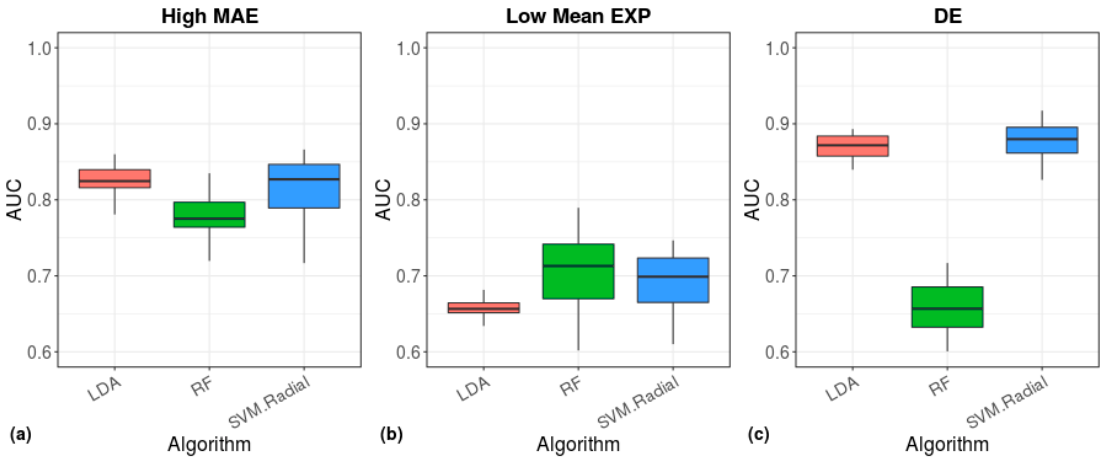
Figure 10. Tissue prediction accuracy of machine-learning algorithms. The area under the ROC curve (AUC), showing the performance of the indicated models in classification of tissue origin. The models were based on cell scores calculated from the 200 high-MAE ( a ), low mean-EXP ( b ), or the DE ( c ) gene sets.